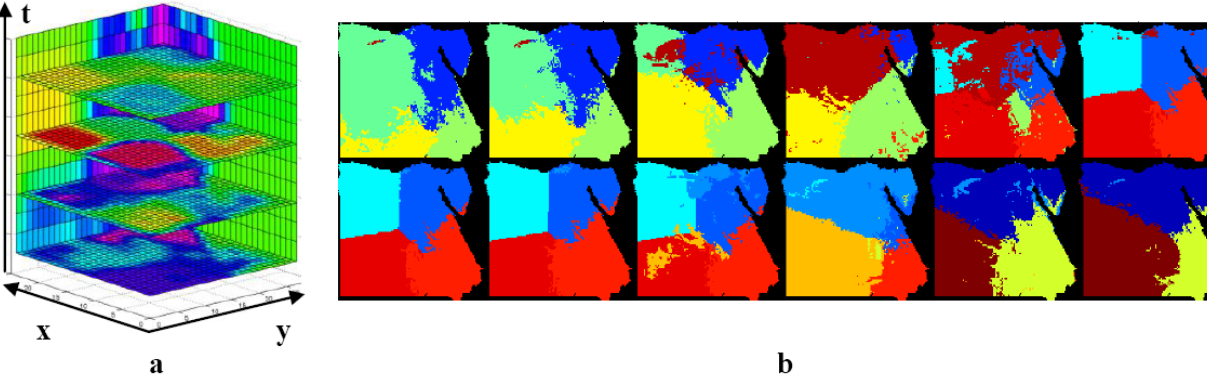
Figure 7. (a) Visualizing colored bulks of three-dimensional clusters under spatiotemporal clustering, (b) 12 two-dimensional temporal slices from spatiotemporal clustering. Slices with irregularly dispersed clusters indicate temperature